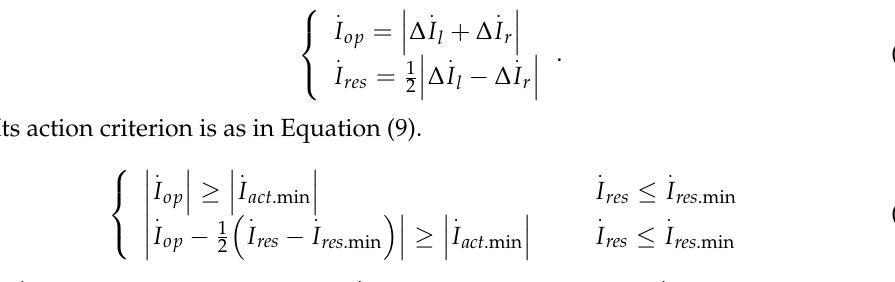
Its action criterion is as in Equation (9).